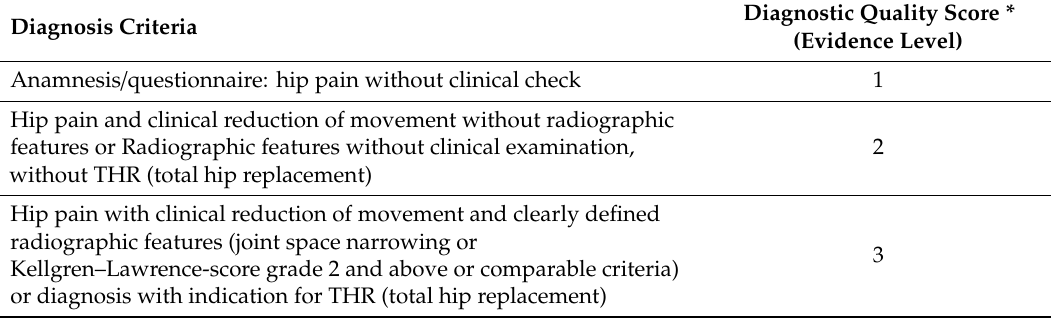
Table 1. Definition of level of evidence for diagnostic evaluation of studies on osteoarthritis (OA) of the hip (score 1–3) [5].